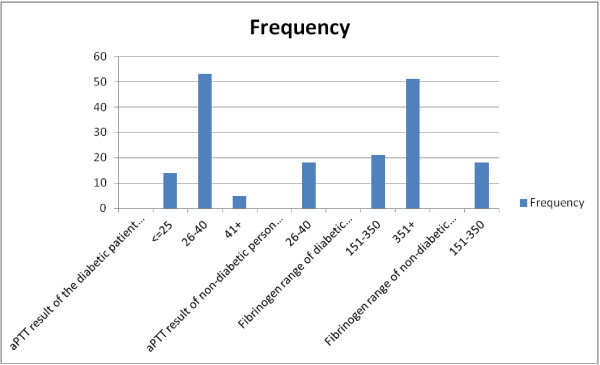
The aPTT and Fibrinogen related characteristics of the study population. (Mean aPTT of diabetics and non-diabetic person =29.88 ± 4.89 seconds and 32.44 ± 2.25 seconds respectively; p value 0.000) (Mean fibrinogen level of diabetics and non-diabetic person =388.57 ± 60.90 mg/dL and 320.89 ± 10.20 mg/dL; p value 0.000).